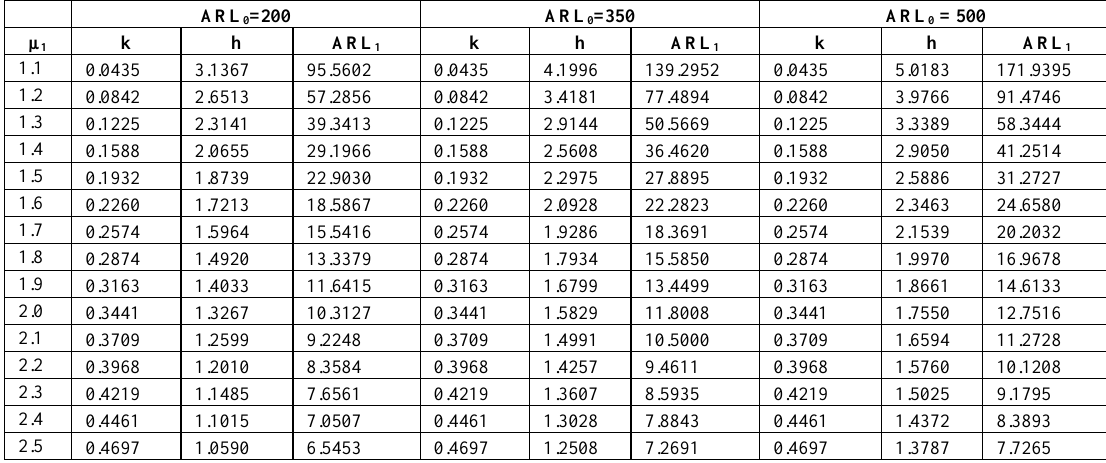
Table 3. Combined Shewhart- CUSUM scheme parameters and out of control ARLs with the varying